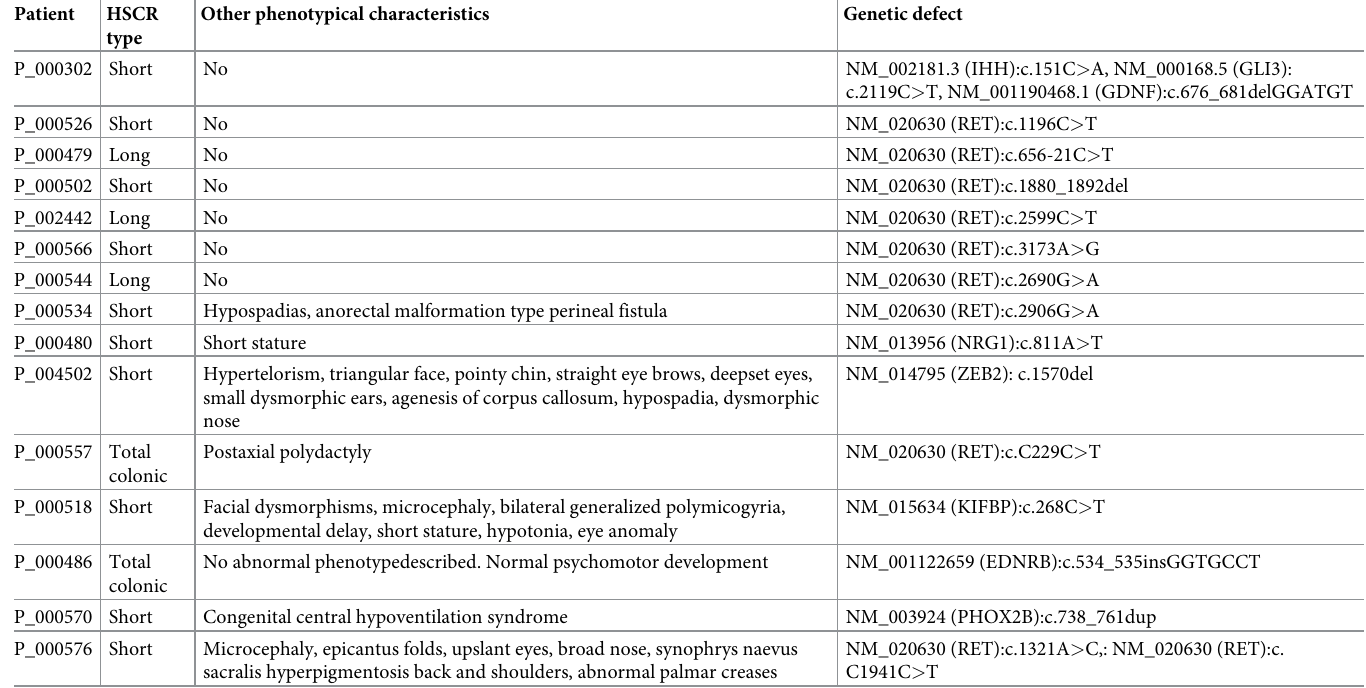
Table 2. HSCR patients with a deleterious